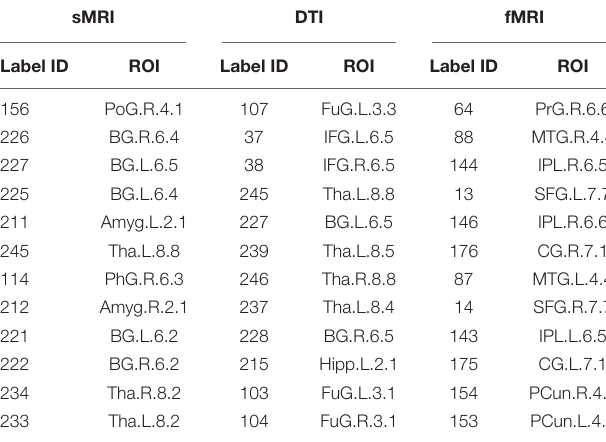
Frontiers in Aging Neuroscience |